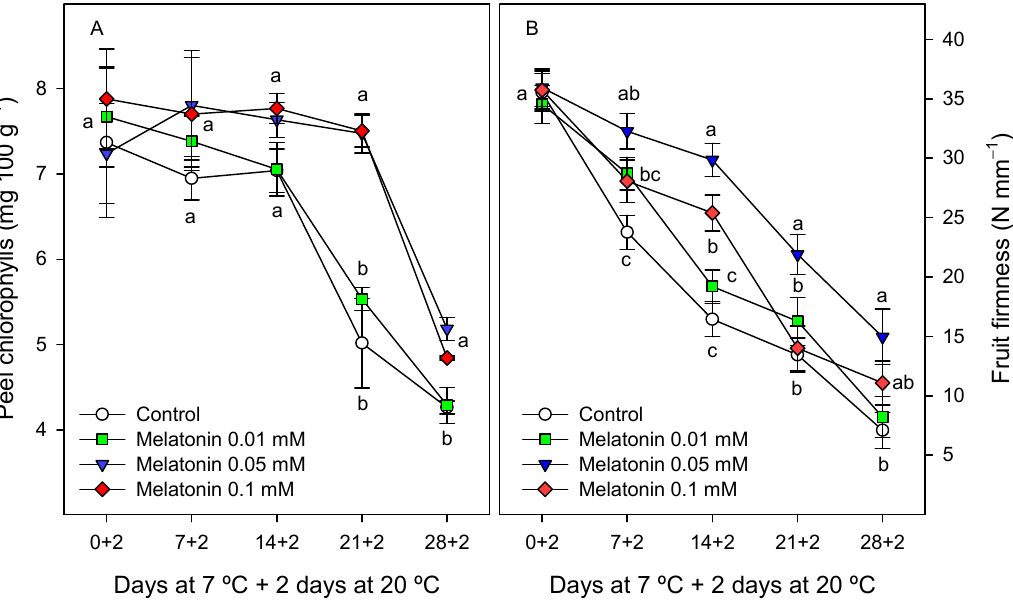
Figure 3. Peel chlorophyll concentration ( A ) and fruit firmness ( B ) as affected by melatonin (0.01, 0.05 and 0.1 mM) treatments. Data are the mean ± SE of three replicates. Different letters show significant differences ( p < 0.05) among treatments for each sapling date.